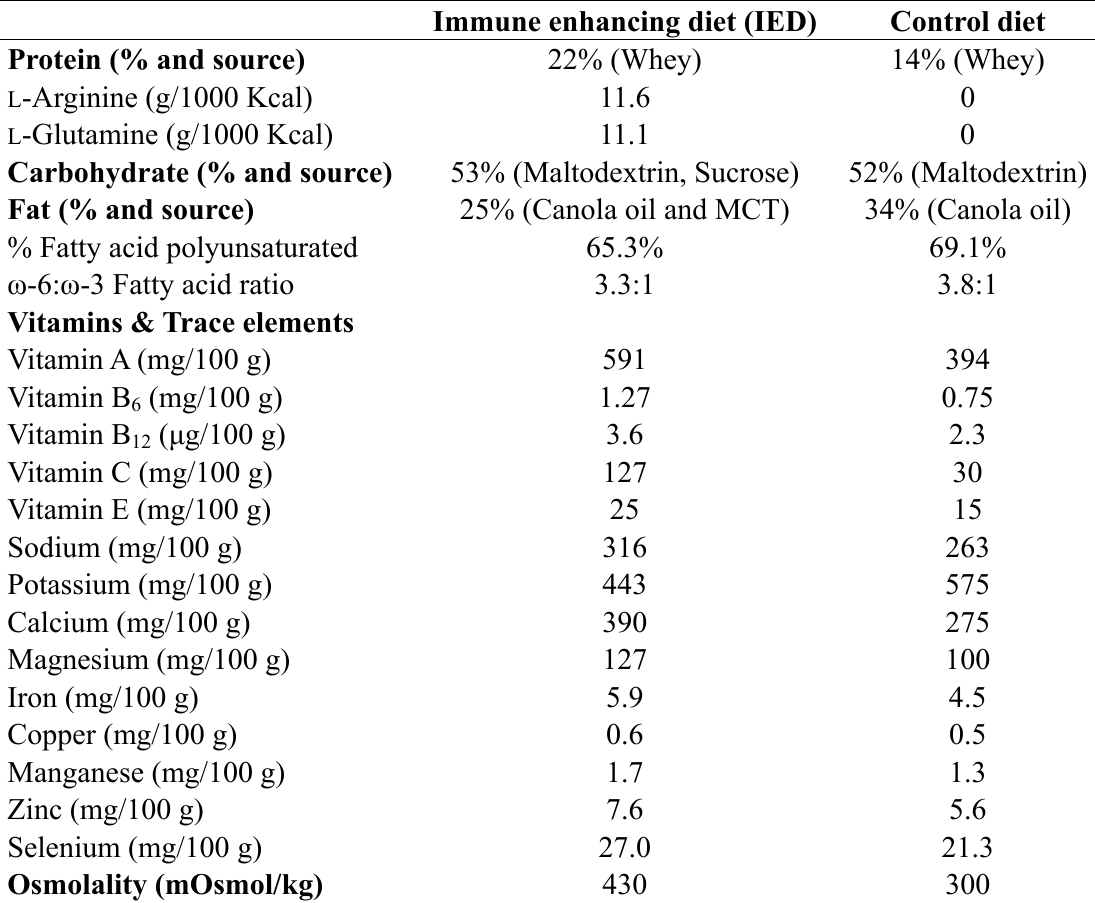
Table 1. Summary of the compositions of immune enhancing diet and control